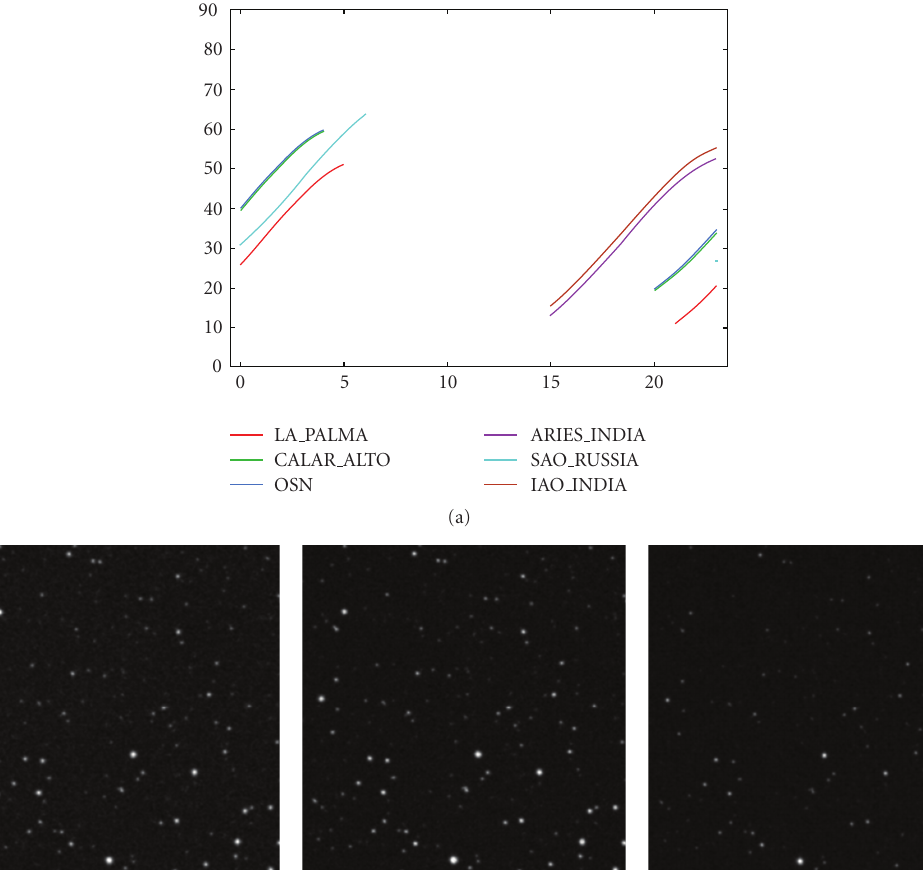
Figure 7: Example of report received for GRB